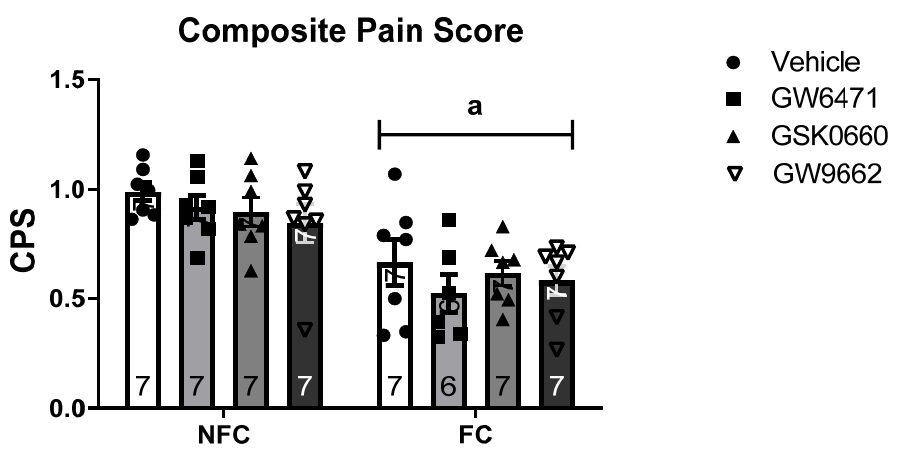
Figure 1. Effects of intra-BLA administration of selective PPAR α , PPAR β / δ , and PPAR γ antagonists on formalin-evoked nociceptive behaviour (CPS; composite pain score) in non-fear conditioned (NFC) and fear conditioned (FC) rats. Data are expressed as mean ± S.E.M ( n = 6–7 rats per group). According to a 2-way ANOVA ( a p < 0.001), significant overall effect of fear conditioning.